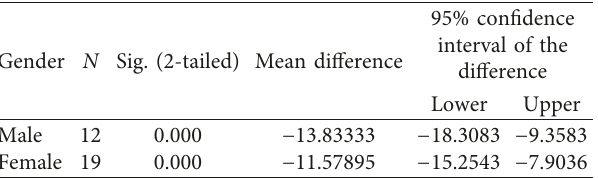
Table 2: Statistic and one-sample t -test for emotional exhaustion with reference to gender.